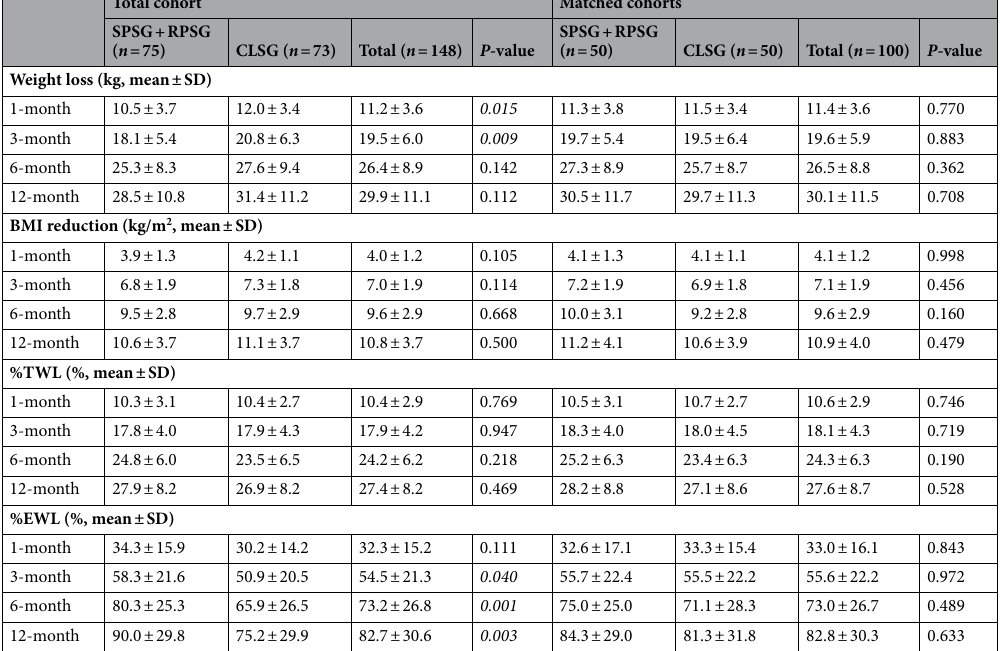
Table 2. Weight loss in the total and propensity score-matched cohorts at 1, 3, 6, and 12-month follow-up after surgery. Significant values are italics. SPSG single-port sleeve gastrectomy, RPSG reduced port sleeve